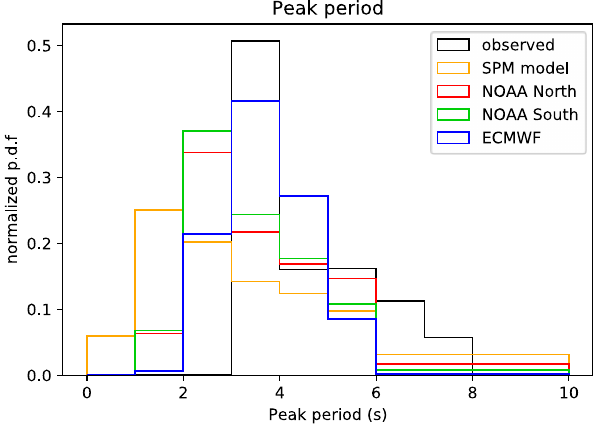
Figure 7. Wave period distribution (normalized p.d.f.) by ADM ins , by NOAA and ECMWF datasets and by SPM ’84.